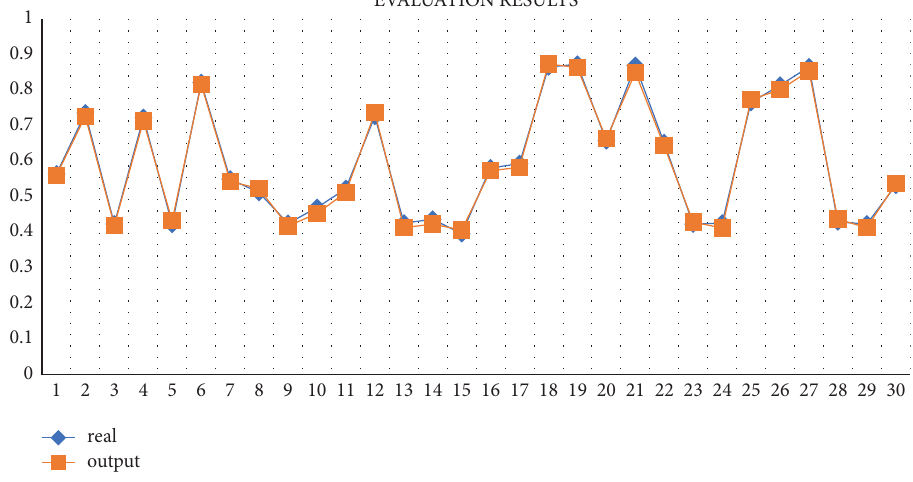
Figure 6: Evaluation results.